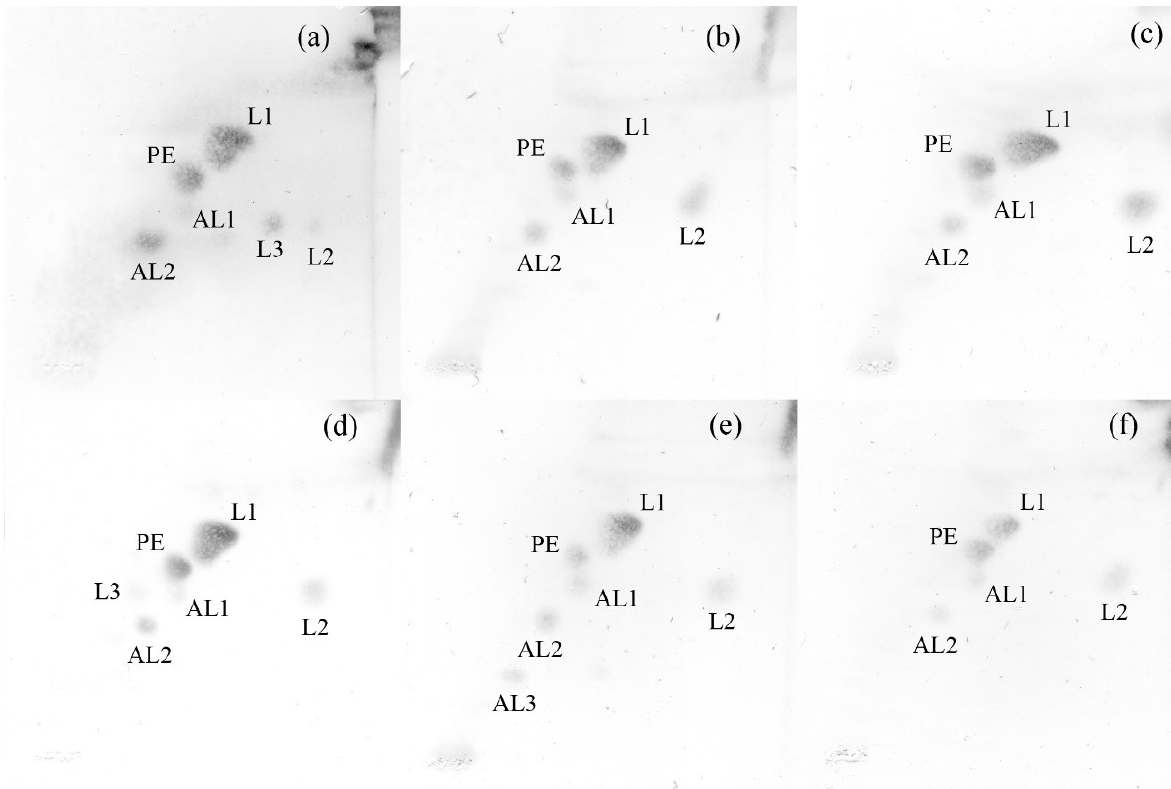
Figure 5. Two-dimensional thin-layer chromatogram of polar lipids extracted from strain 36-CHABK-3-33 T . ( a ) Zobellia galactanivorans CIP 106680 T ; ( b ) Zobellia amurskyensis KMM 3526 T ; ( c ) Zobellia laminariae KMM 3676 T ; ( d ) Zobellia russellii KMM 3677 T ; ( e ) and Zobellia uliginosa CIP 104808 T ; ( f ) PE, phosphatidylethanolamine; AL1 and AL2, unidentified amino lipids; L1–3, unidentified lipids.